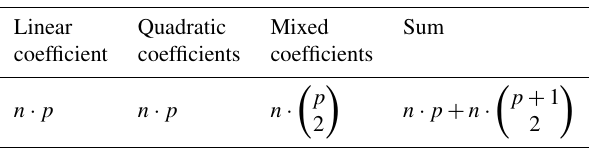
Table 1. Number of coefficients for an n -component transducer with p measuring points (Giesecke,